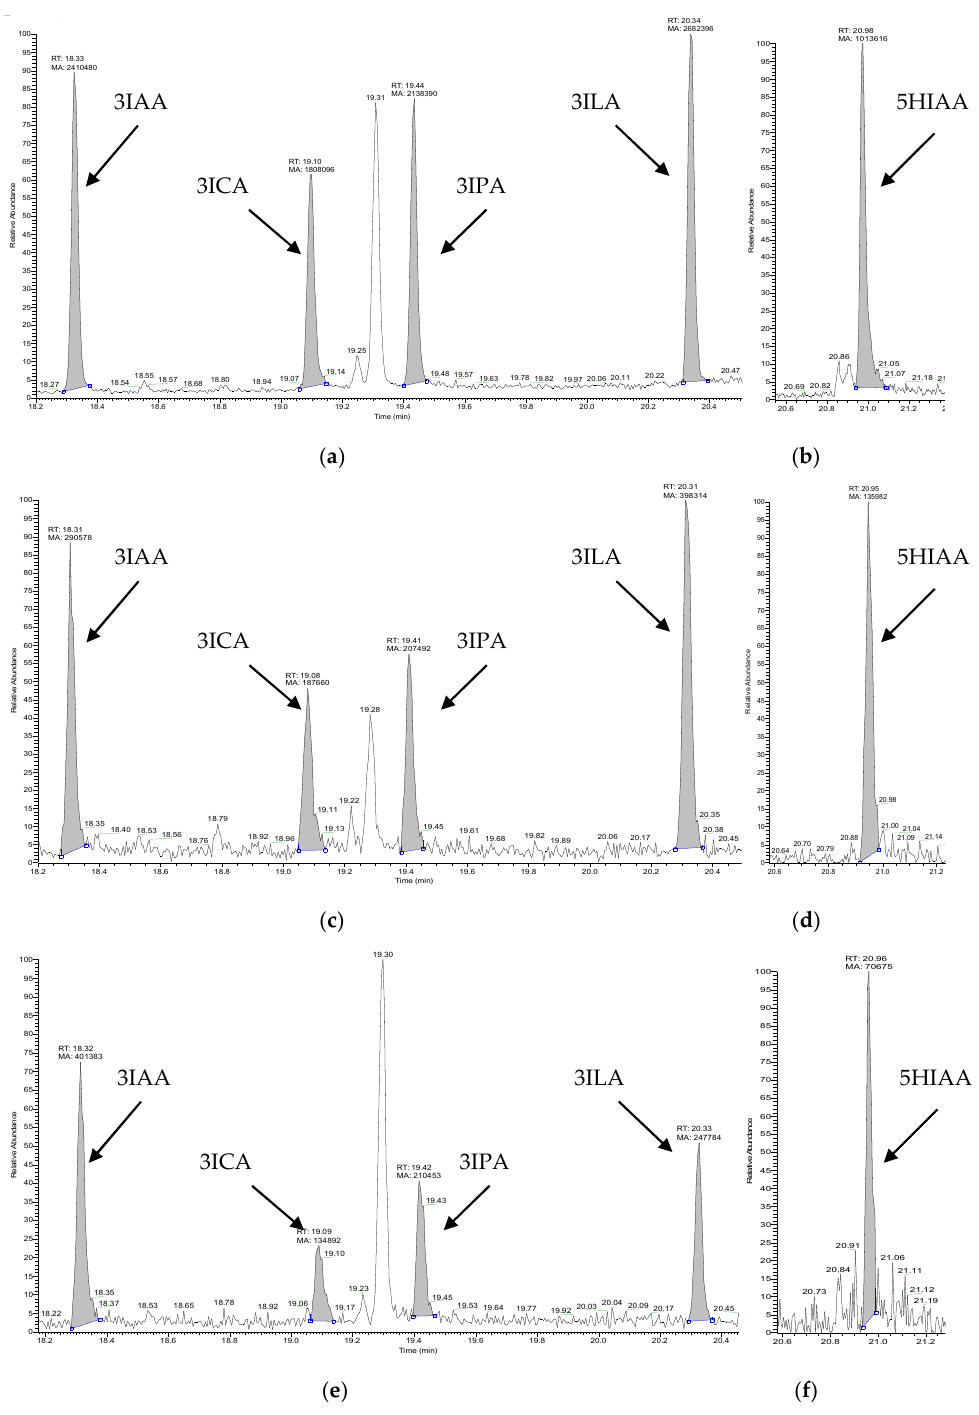
Figure 2. Mass chromatograms of a model solution ( a , b ), pooled cerebrospinal (CSF) sample ( c , d ) and serum sample of a healthy donor ( e , f ) after microextraction by packed sorbent (MEPS) with the addition of the indolic acids (concentration of each acid 500 µg/L / 2.0-2.5 µM) obtained using m/z values (130, 143, 174, 218, 247) of the trimethylsilyl (TMS) derivatives of indole-3-acetic acid (3IAA), indole-3-carboxylic acid (3ICA), indole-3-propionic acid (3IPA), indole-3-lactic acid (3ILA) ( a , c , e ) and m/z values (218, 335) of the TMS derivatives of 5-hydroxyindole-3-acetic acid (5HIAA) ( b , d , f ).